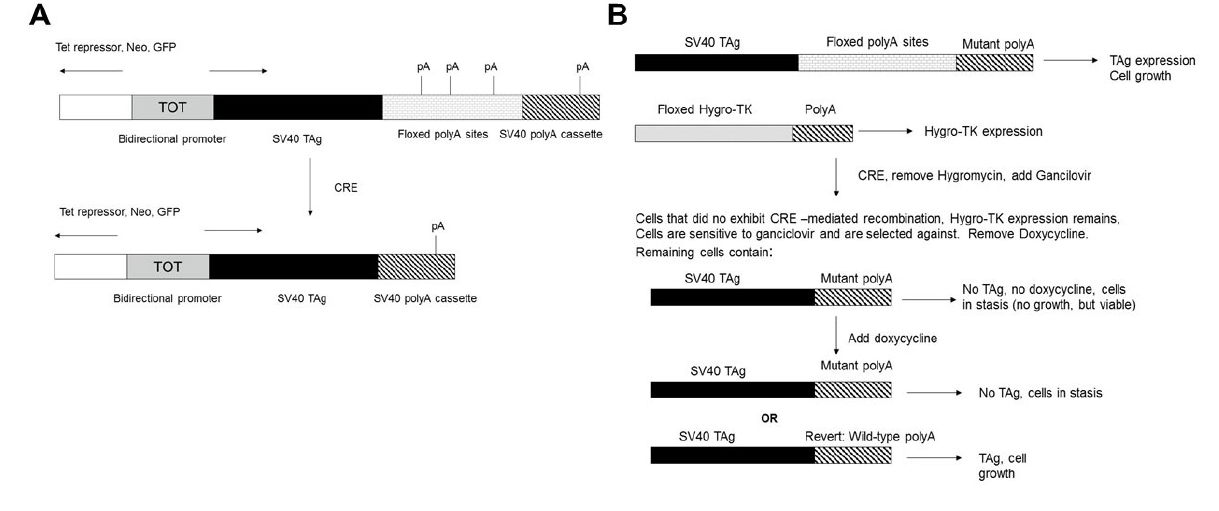
Figure 1. Basic strategy for pRITAGKHexa experiments. (A) Plasmid structure. (B) Outline of the experimental approach.